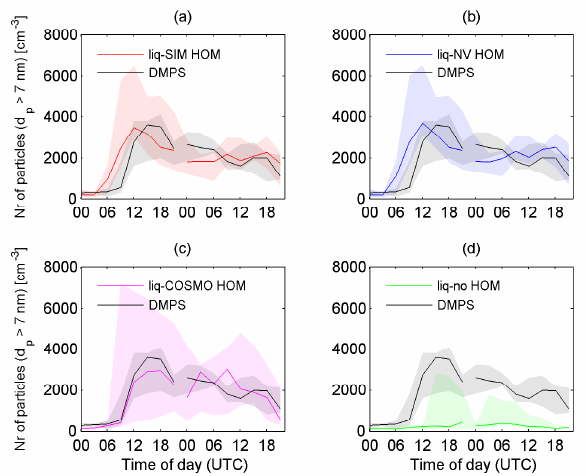
Figure 5. Median number of particles above 50nm of all chosen NPF events at Pallas (from midnight on the day of the event to the evening the day after the start of the event) together with the 25 and 75 percentiles (shaded areas). The black lines are the median DMPS data from Pallas. The colored lines in (a–c) are the modeled median number of particles above 50nm, using different methods to estimate the vapor pressures of the HOMs (see Table 1). In (d) , HOMs are excluded.